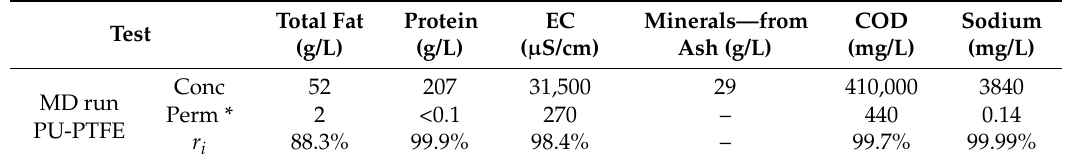
Table 5. FStW MD separation results of measured components using PU-PTFE membrane. Original stick water properties shown in Table